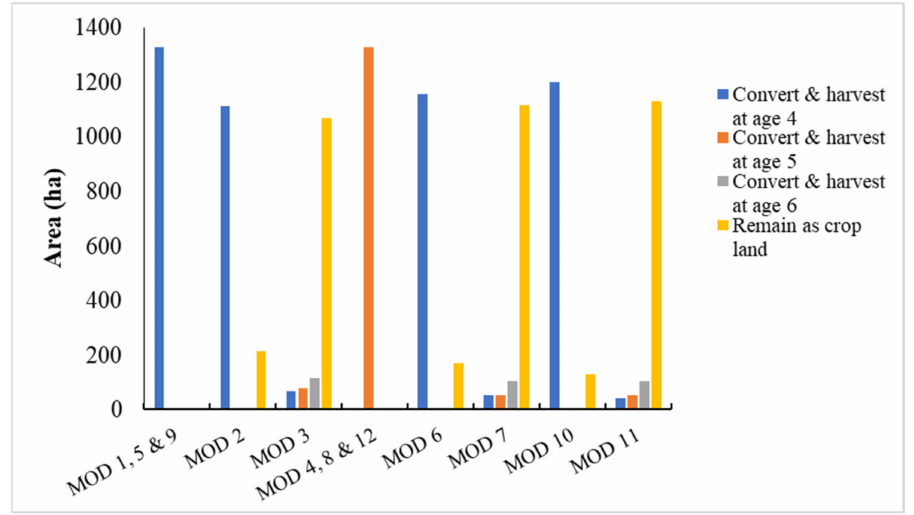
Figure 5. Area assigned to each prescription in each decision